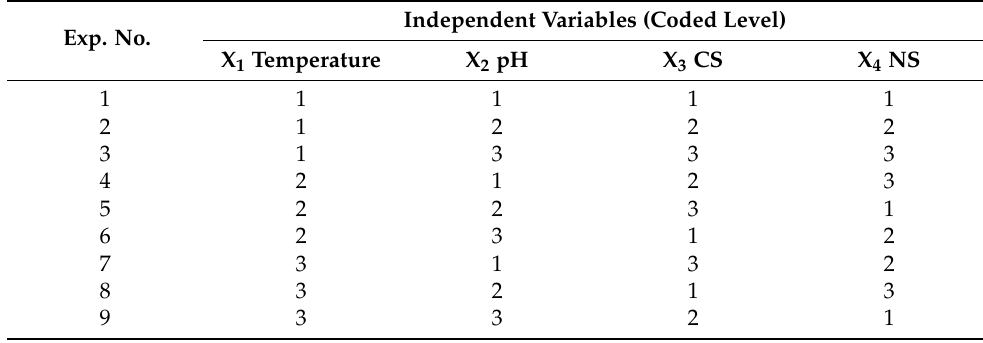
Table 2. The 3 4 Taguchi design; coded values for the independent variables. Exp. No.